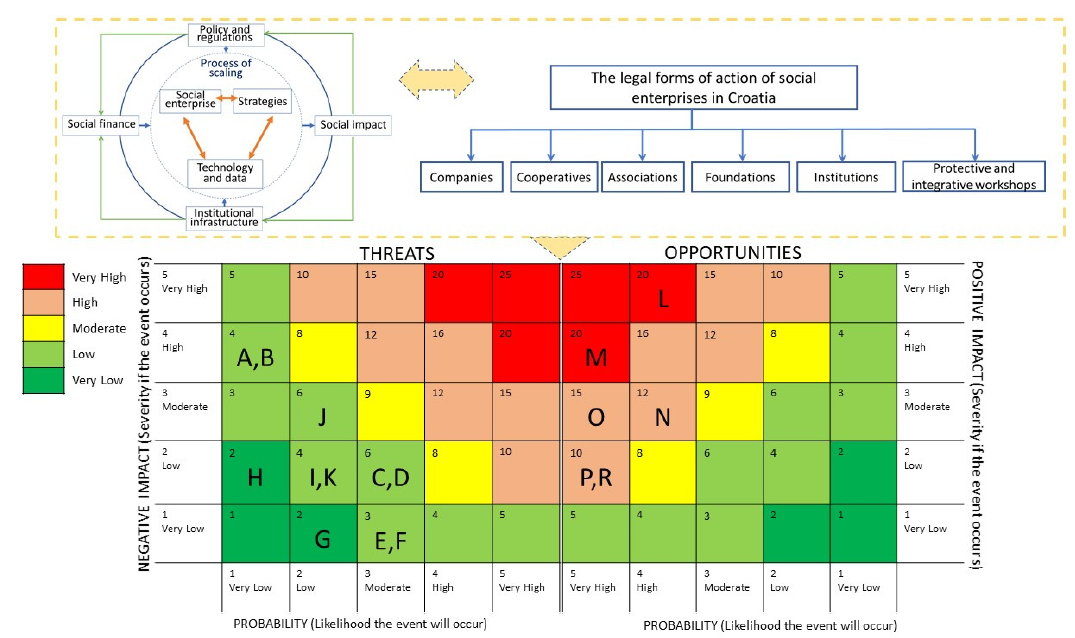
Figure 7. Probability and impact matrix. Source: Authors.